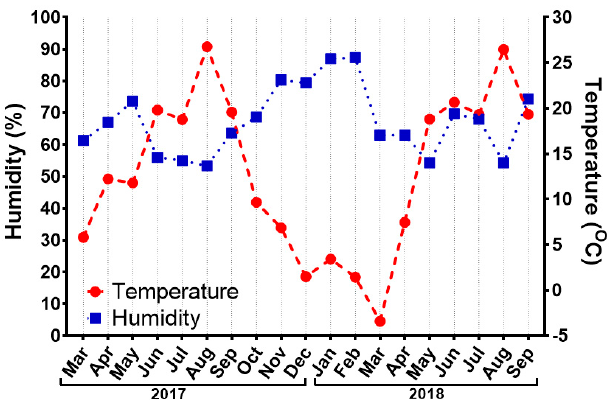
Figure 3. Changes in humidity (blue squares, left y -axis) and temperature (red dots, right y -axis) at the location of the apiary where honey bees were collected. Each point represents the mean value of measurements three days before the collection and on the day of collection.